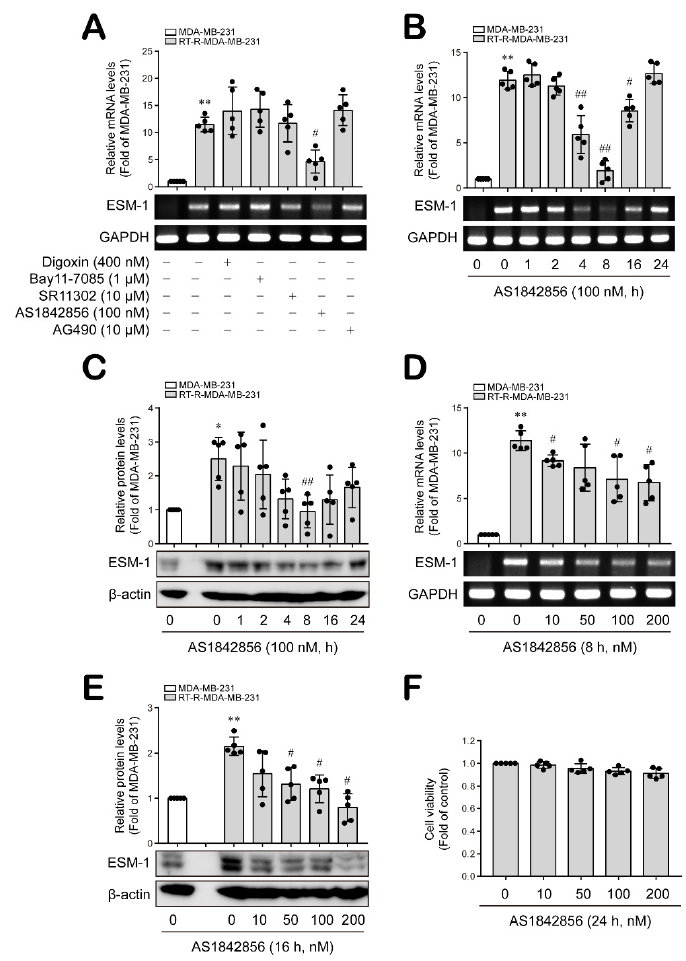
Figure 1. ESM-1 overexpression in RT-R-MDA-MB-231 cells compared to MDA-MB-231 cells was downregulated by an inhibitor of FoxO1. ( A ) MDA-MB-231 and RT-R-MDA-MB-231 cells were treated with the indicated inhibitors (digoxin, a HIF-1 α inhibitor; Bay11-7085, an NF- κ B inhibitor; SR11302, an AP-1 inhibitor; AS1842856, a FoxO1 inhibitor; and AG490, a STAT-3 inhibitor) for 8 h, and then ESM-1 and GAPDH mRNA expression levels were analyzed with total RNA extracted from the cells by RT–PCR. The results are presented as the mean ± SD of five independent experiments. ** p < 0.01 compared to the MDA-MB-231 cells; # p < 0.05 compared to the untreated RT-R-MDA-MB-231 cells. ( B – E ) MDA-MB-231 and RT-R-MDA-MB-231 cells were treated with AS1842856, and ESM-1 mRNA expression levels ( B , D ) and protein expression levels ( C , E ) were analyzed by RT-PCR and Western blotting, respectively. GAPDH and β -actin were used as loading controls. The results are presented as the mean ± SD of five independent experiments. * p < 0.05, ** p < 0.01 compared to the MDA-MB-231 cells; # p < 0.05, ## p < 0.01 compared to the untreated RT-R-MDA-MB-231 cells. ( F ) RT-R-MDA-MB-231 cells were treated with the indicated doses of AS1842856 for 24 h, and cell viability was measured by cell counting kit (CCK) viability assay. The results are presented as the mean ± SD of five independent experiments.